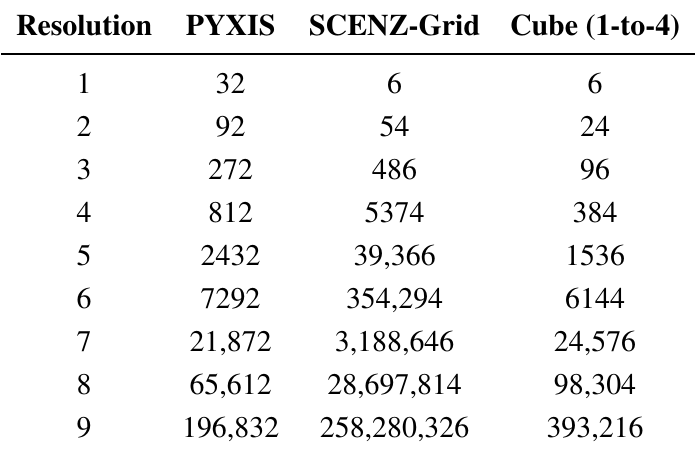
Table 1. Number of cells at each resolution in three different frameworks. Note that under the PYXISframework, the first resolution starts from 12 pentagons and 20 hexagons created on the